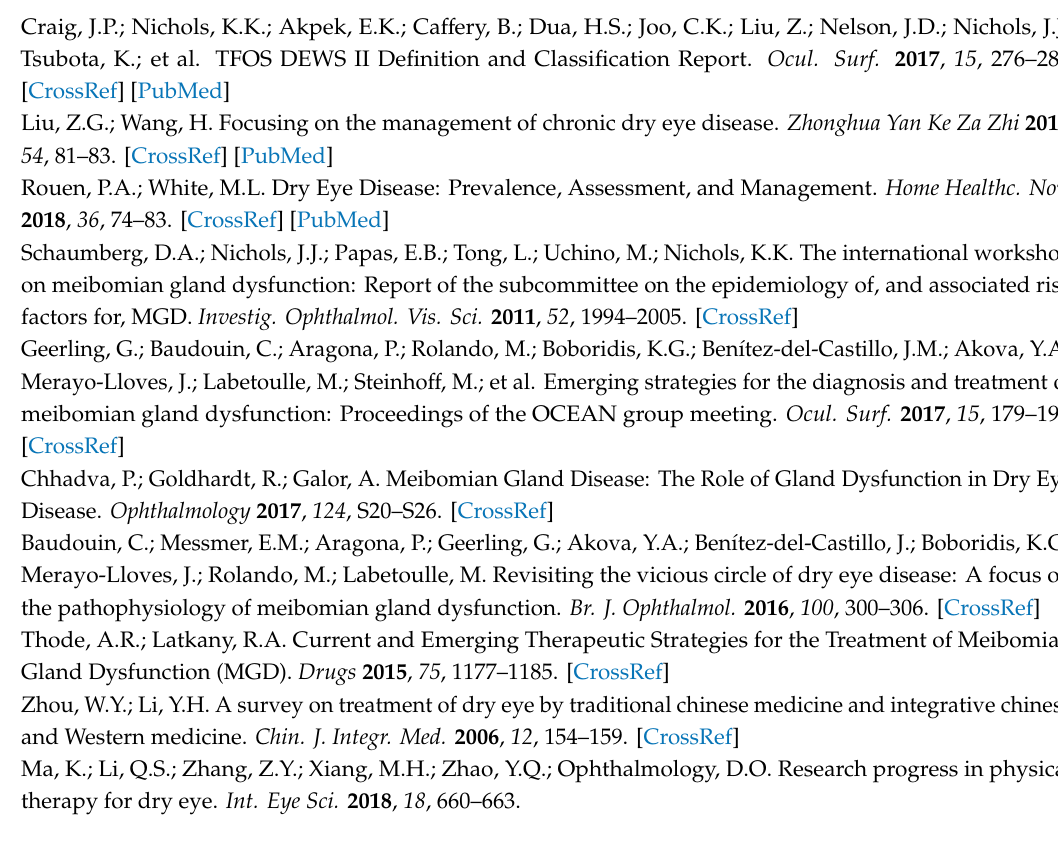
Figure S1: The ultrasonic nebulizer, Table S1: Specific distribution of cases at each center, Table S2: Ocular symptom rating scale, Table S3: Characteristics of the patients at baseline, Table S4: Changes in individual eye symptom after 4-week treatment, Table S5: Correlation between indicator change and that at baseline, Table S6: Adverse events during the